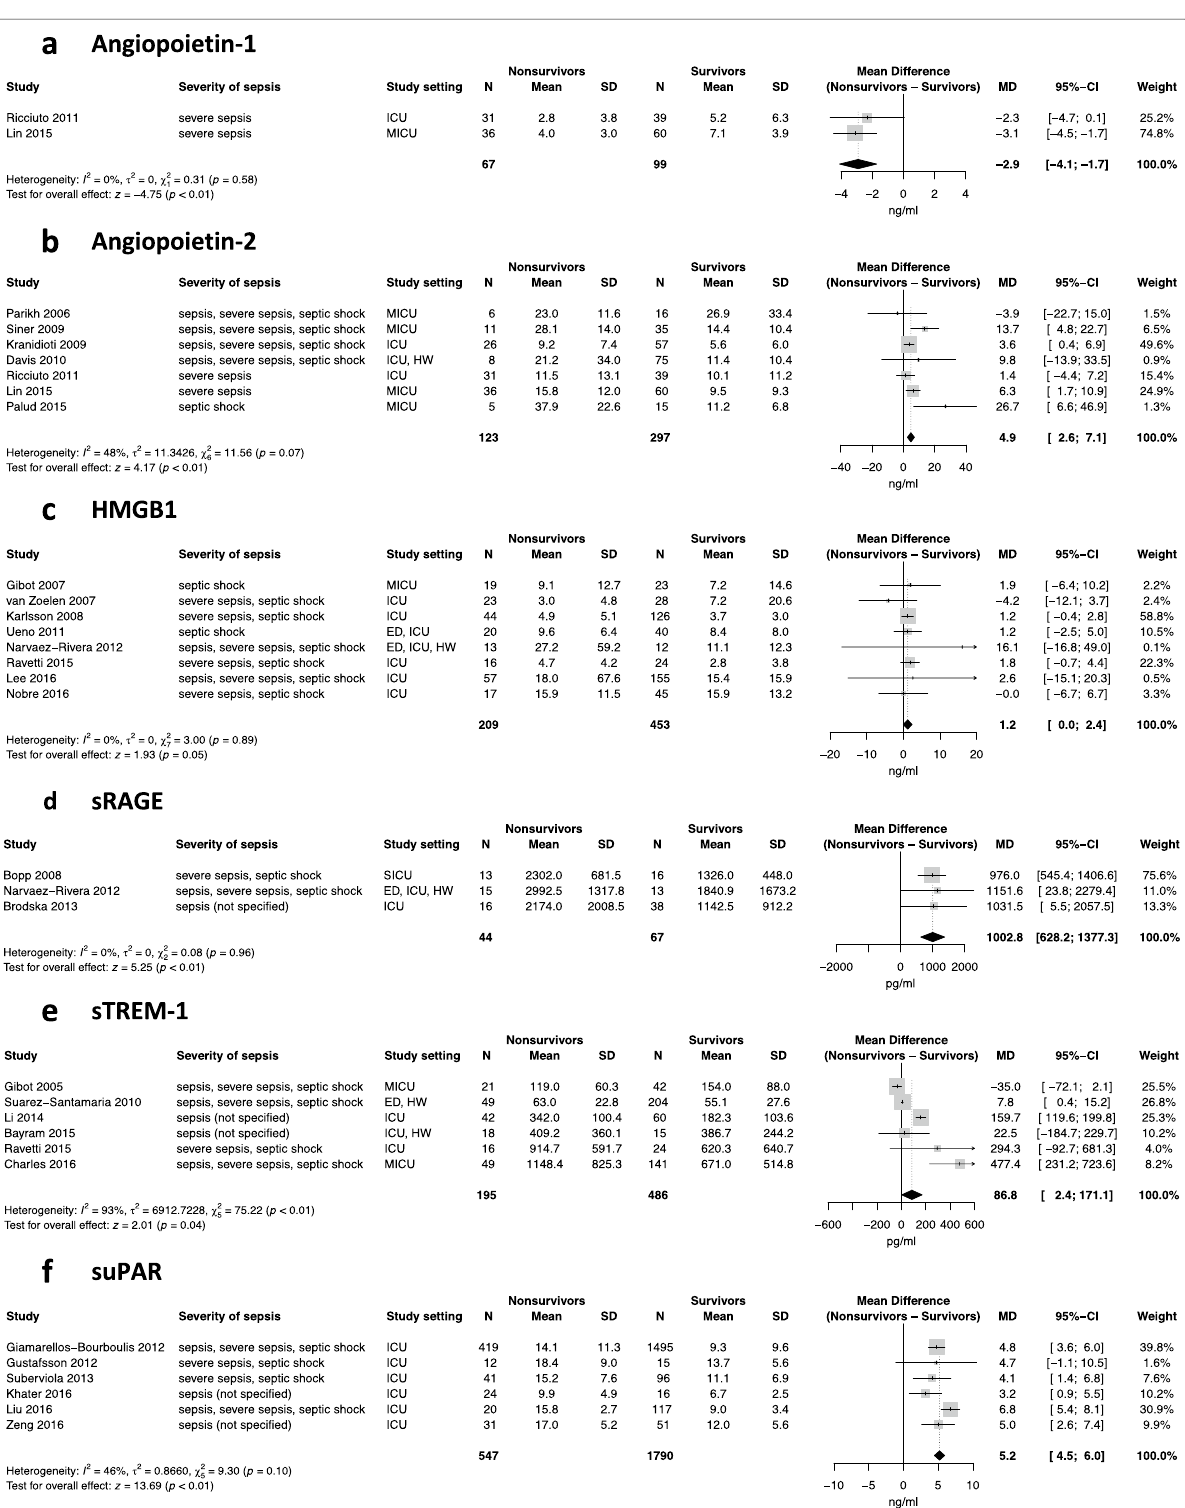
survivors). Effect estimates to the left of 0 indicate −